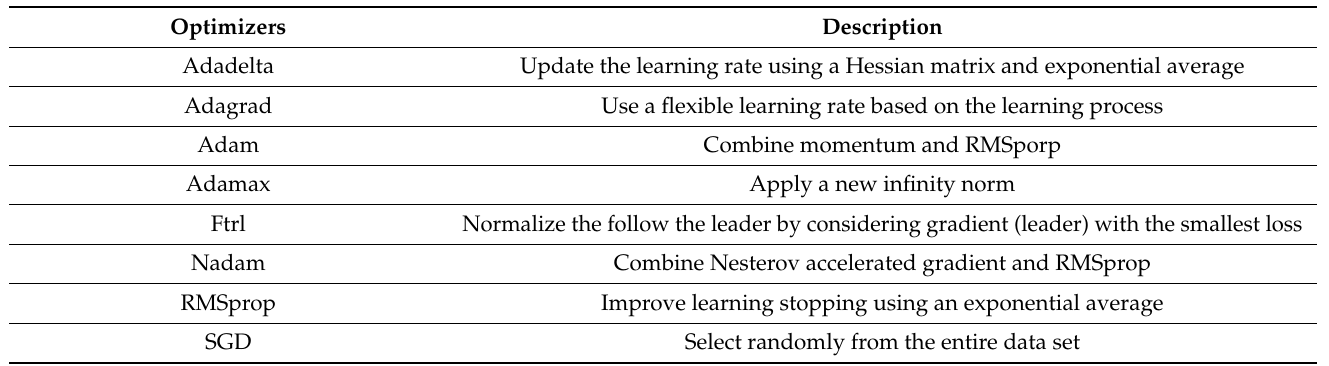
Table 1. Existing optimizers in this